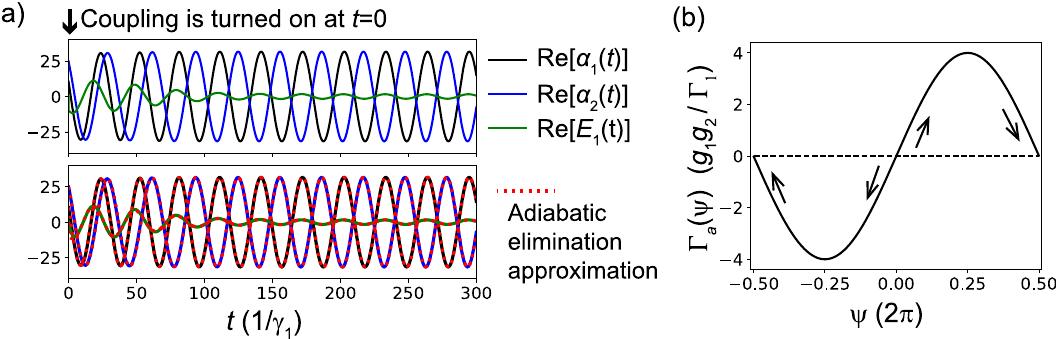
Figure 3. ( a ) Time evolution of the fields Re [ α 1,2 ( t ) ] and Re [ E ( t ) 1 ] , but coupling ( g 1,2 = 0.1 γ 1 ) is turned on at t = 0 , which represents synchronization dynamics. The upper panel shows the time evolutions of the fields calculated with the original coupled-mode equations. In the lower panel, the time evolutions of the fields calculated with the adiabatic elimination approximation are shown as red dashed lines with the original plots. The shifted frequencies of the laser and cold cavities are ω ′ 1 = 0.2 γ 1 , ω ′ 2 = 0.21 γ 1 , and � ′ 1 = 0.2 γ 1 . ( b ) Anti- symmetric part of the phase coupling function Ŵ a (ψ) given by Eq. (16), where ψ is the phase difference between the two laser phases defined as ψ ≡ φ 2 − φ 1